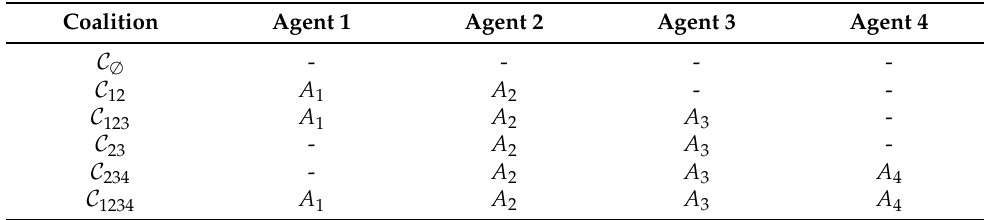
Table 3. Possible communication topologies.